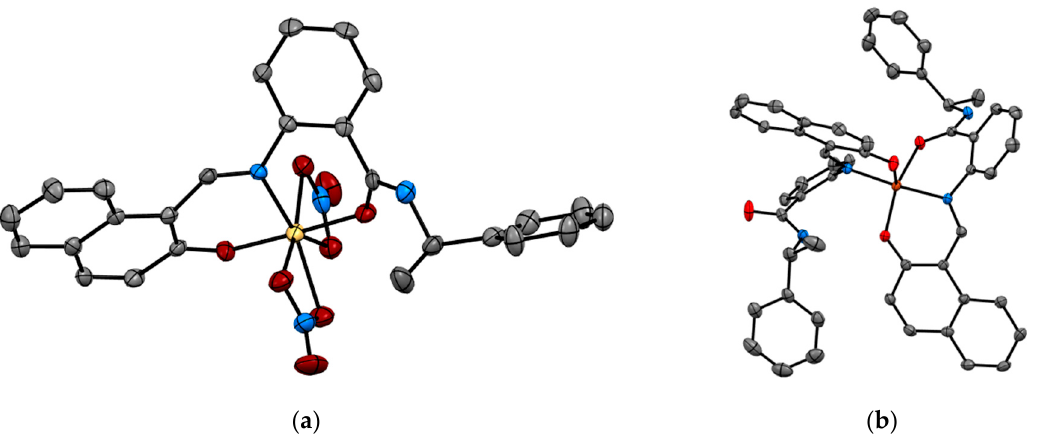
Figure 3. Metal complexes of sirtuin inhibitor, sirtinol with Fe(III) and Cu(II) ( a ) [Fe III (sirtinol-H)(NO 3 ) 2 ] (CCDC 1036424) and ( b ) Cu II (sirtinol − H) 2 (CCDC 1402316). Hydrogen atoms are omitted for clarity. Ref. [13,14] .